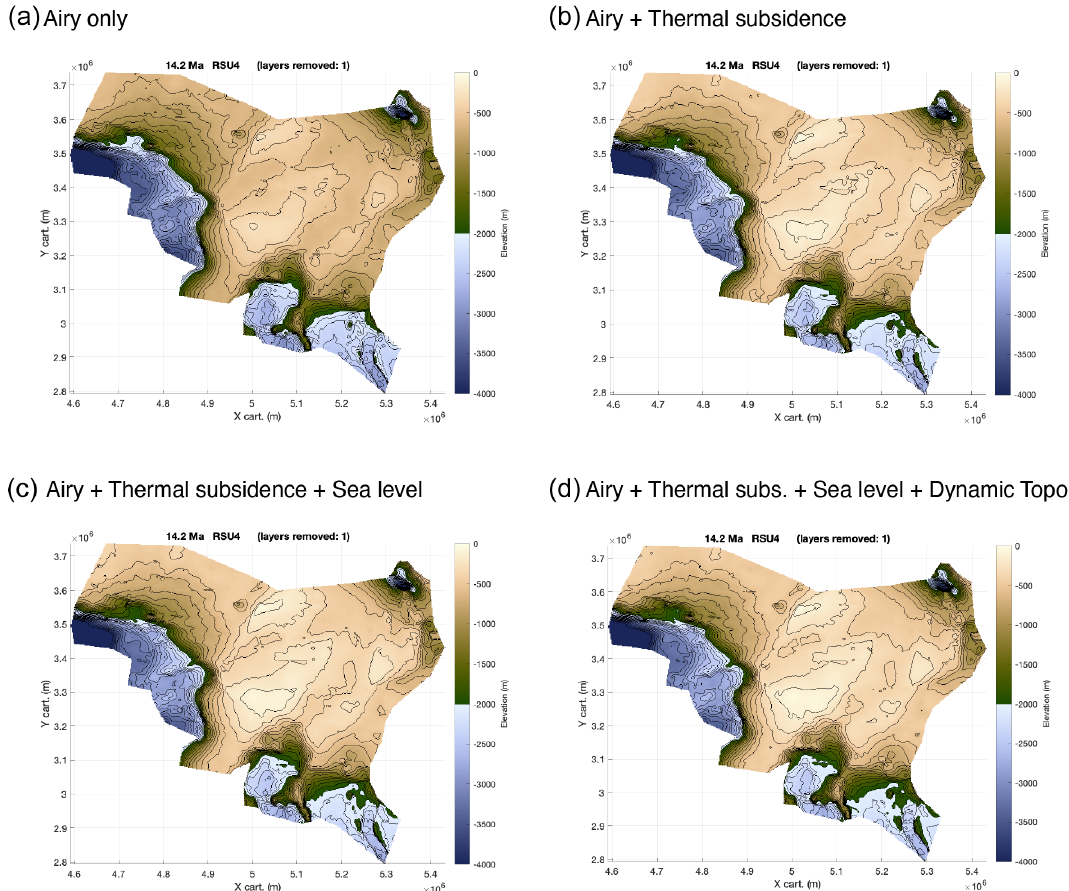
Figure 10. Backtracked mid-Miocene bathymetries at about 14Ma: (a) corrected only for Airy isostasy, (b) the same as (a) but including thermal subsidence correction with a spatially uniform β = 2 . 1 and the end of rifting sets at 76Ma, (c) the same as (b) but including eustatic sea level correction based on Miller et al. (2020) δ 18 O-derived reconstruction, (d) the same as (c) but including dynamic topography correction based on the Müller et al. (2018a) geodynamical model M1 (following Hochmuth et al., 2020). Layout is from the PALEOSTRIP plotting GUI; the colour scale is the default colour scale implemented within PALEOSTRIP and has been saturated below − 4000m and above 200m for this figure. The island located in the uppermost right corner is the only location with an elevation above sea level. Note that the colour scale is colour-blind friendly and is from Crameri et al. (2020). PALEOSTRIP has implemented 12 different colour scales, and 9 out of 12 are colour-blind friendly. For all parameters used in these examples, see Table